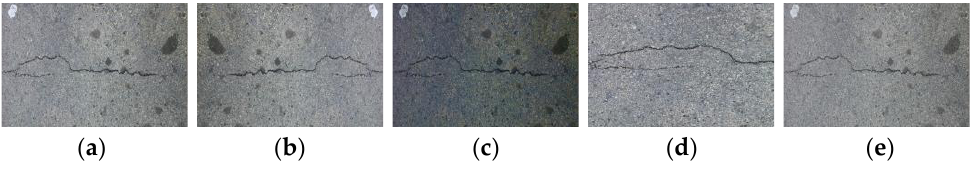
Figure 11. Different types of data augmentation methods. ( a ) Original Image; ( b ) Flipping Transfor- mation; ( c ) Contrast Transformation; ( d ) Random Cropping; ( e ) Noise. Table 5. The comparison results of data augmentation. Data